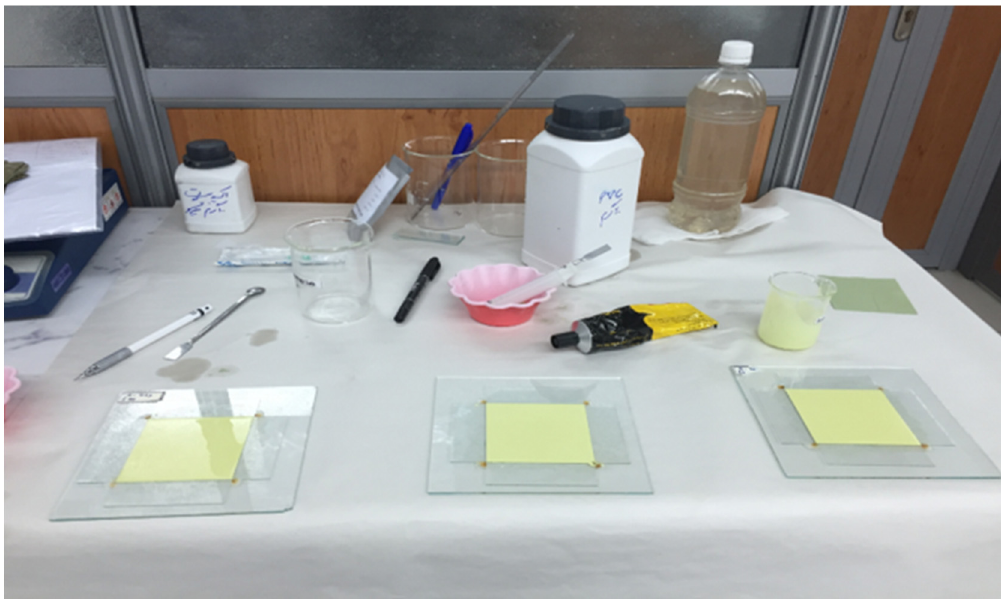
Figure 1. Preparation of tungsten and bismuth nano- and micro-structured prototypes.